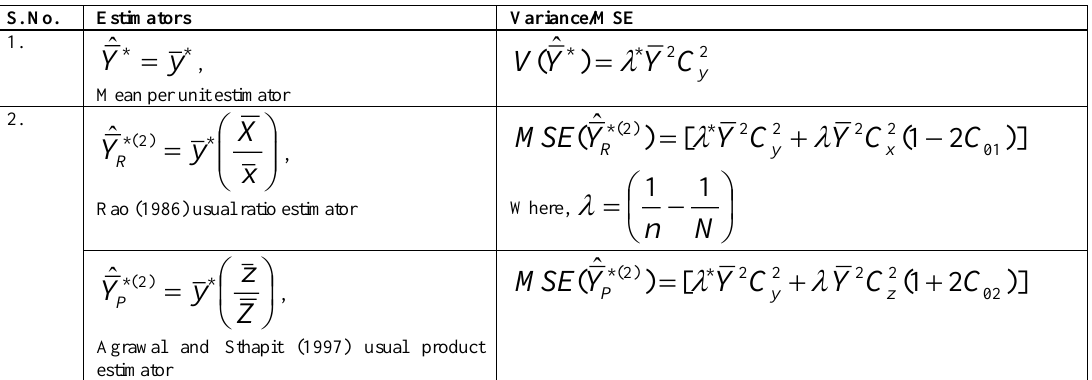
Table 3. Competing estimators under second strategy of non-response along with their